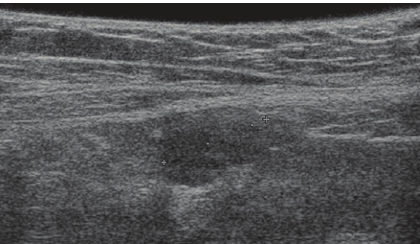
Figure 2: A 22-year-old girl/female with CAIS. Transabdominal ultrasonography (Hitachi EUB-8500, 14MHz linear array probe) shows the presence of the right testis in the inguinal